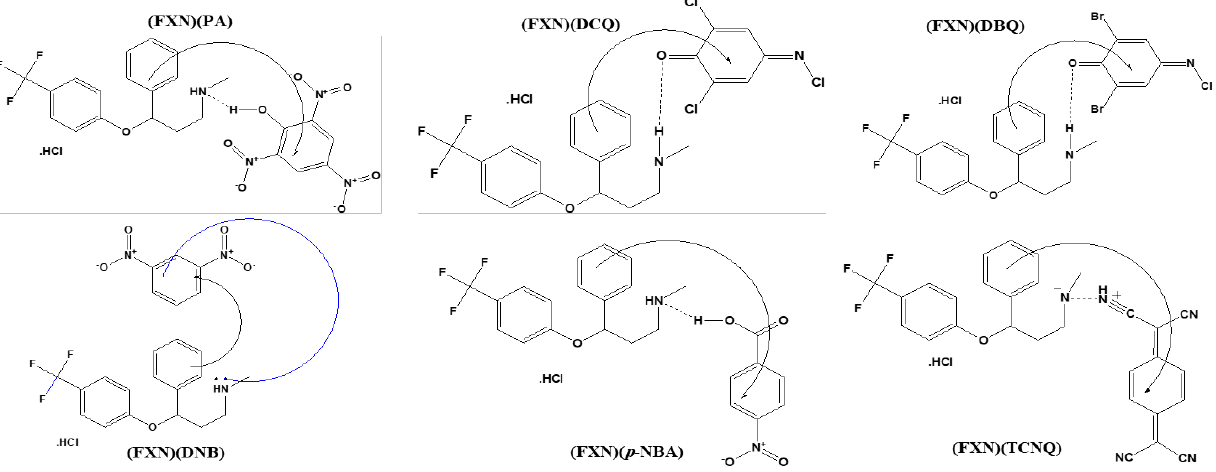
Figure 2. Molecular structures between FXN and the six π -acceptors.